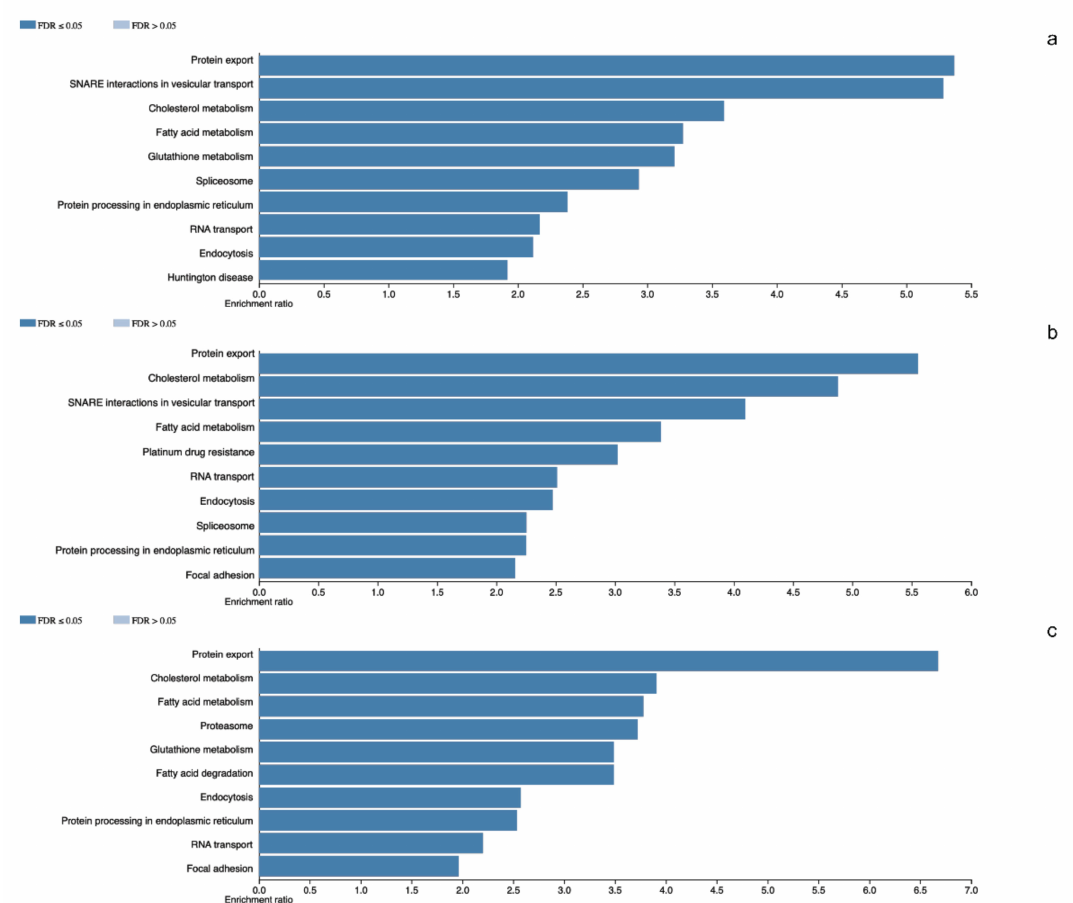
Figure 1. Panel ( a – c ) denotes the altered cellular events in which total proteins participates in NR5A1 - and POU1F1 -derived pituitary tumors and total detected proteins in control glands,